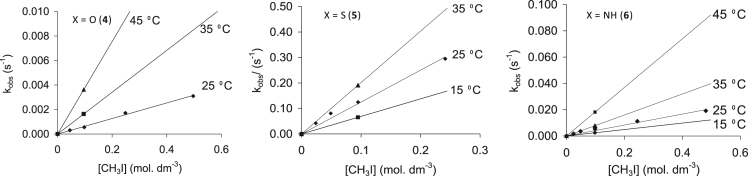
The temperature and methyl iodide concentration dependence of the oxidative addition reaction between CH3I and Rh(H3CCOCHCOCH3)CO(C6H5XPPh2), where X = O (4), S (5) and NH (6) as monitored by UV/vis.